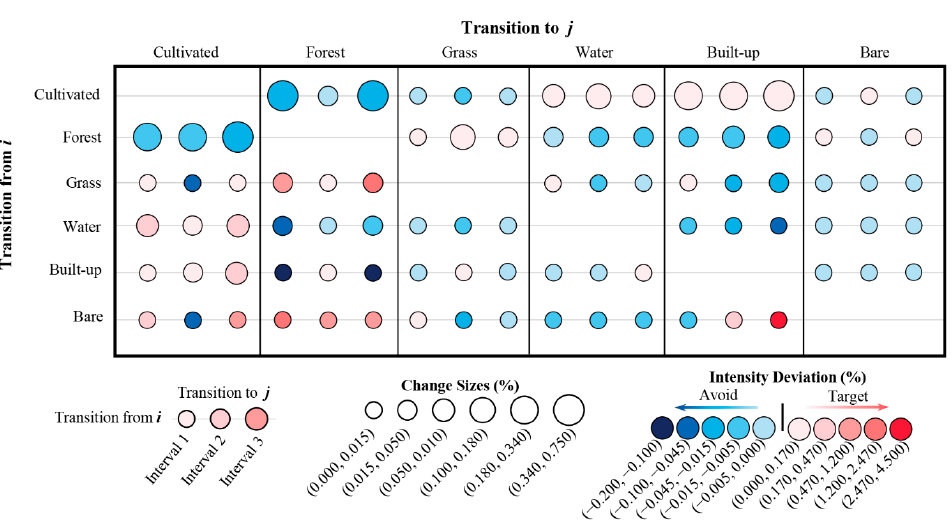
Figure 7. Annual transition size and intensity of the transition from other categories to built-up land at three intervals ( a ) 1980–1995, ( b ) 1995–2005, ( c ) 2005–2015); ( d ) magnified view of intensity from 1980–1995.